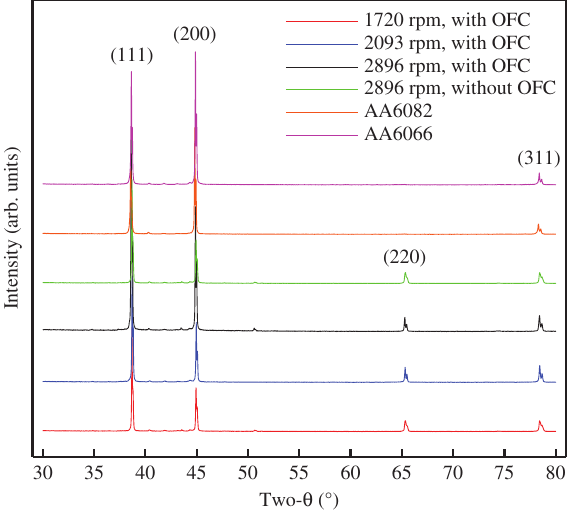
Figure 12: Tensile properties of dissimilar metal butt joints under different welding